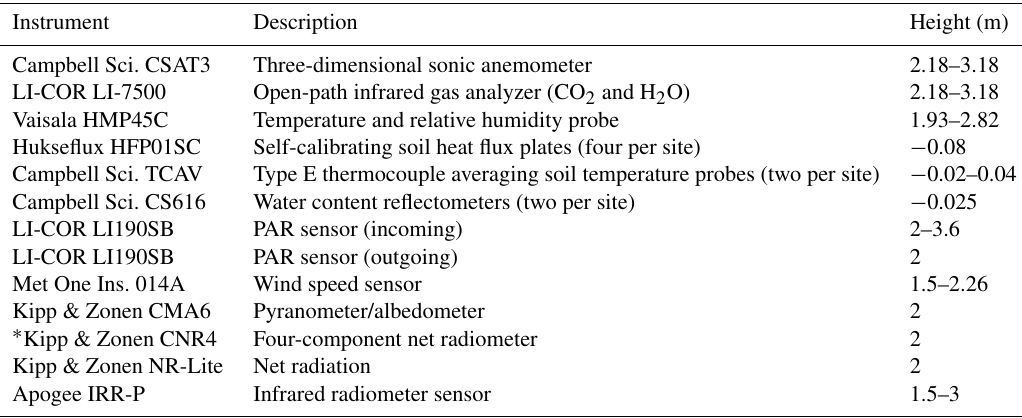
Table 2. General overview of the Fen, Tussock and Heath flux sites instrumentation (more information is available at http://aon.iab.uaf. edu/imnavait). Apogee infrared radiometers were oriented 45 ◦ off nadir at the three flux stations. Negative measurement of height indicate measurements of